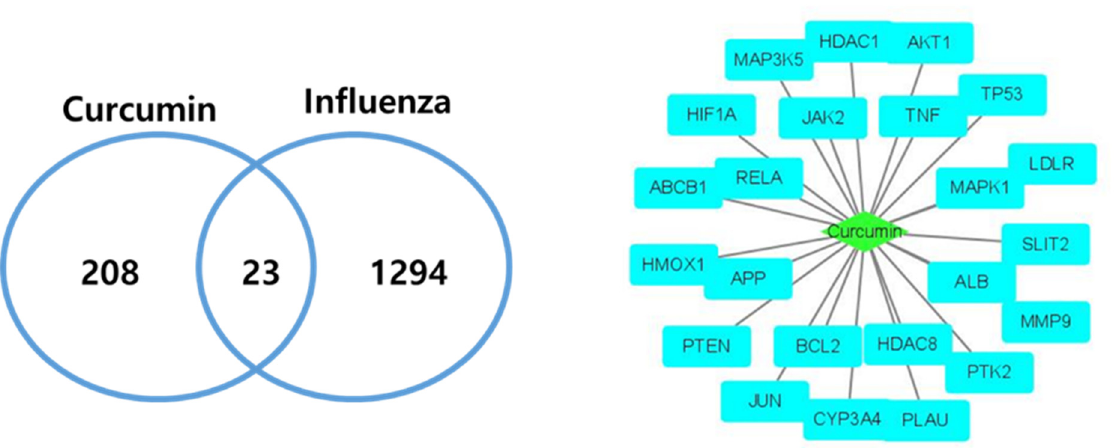
Figure 2. Curcumin–Influenza-associated targets. In total, 23 curcumin and influenza infection common targets were retrieved and constructed as a network.